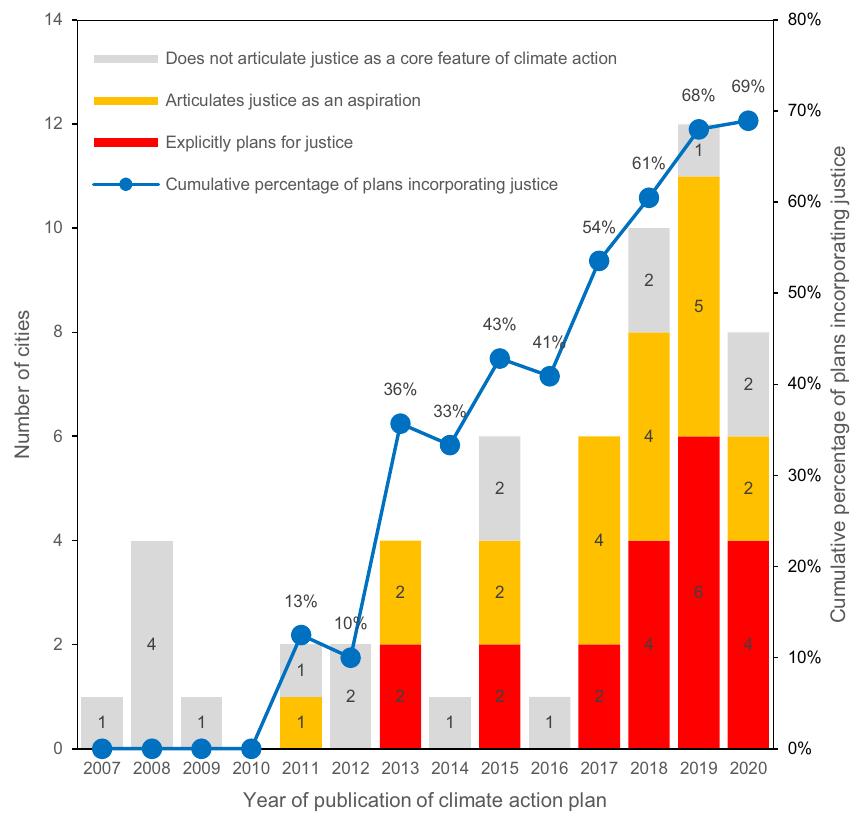
Fig.1|Engagementwithclimatejusticeovertime. Numberofcitiesinoursample that adopted or updated a climate action plan between 2007 and 2020. Cities are categorised according to their level of engagement with justice in policy action: cities that do not articulate justice as a core feature of climate action (grey), cities